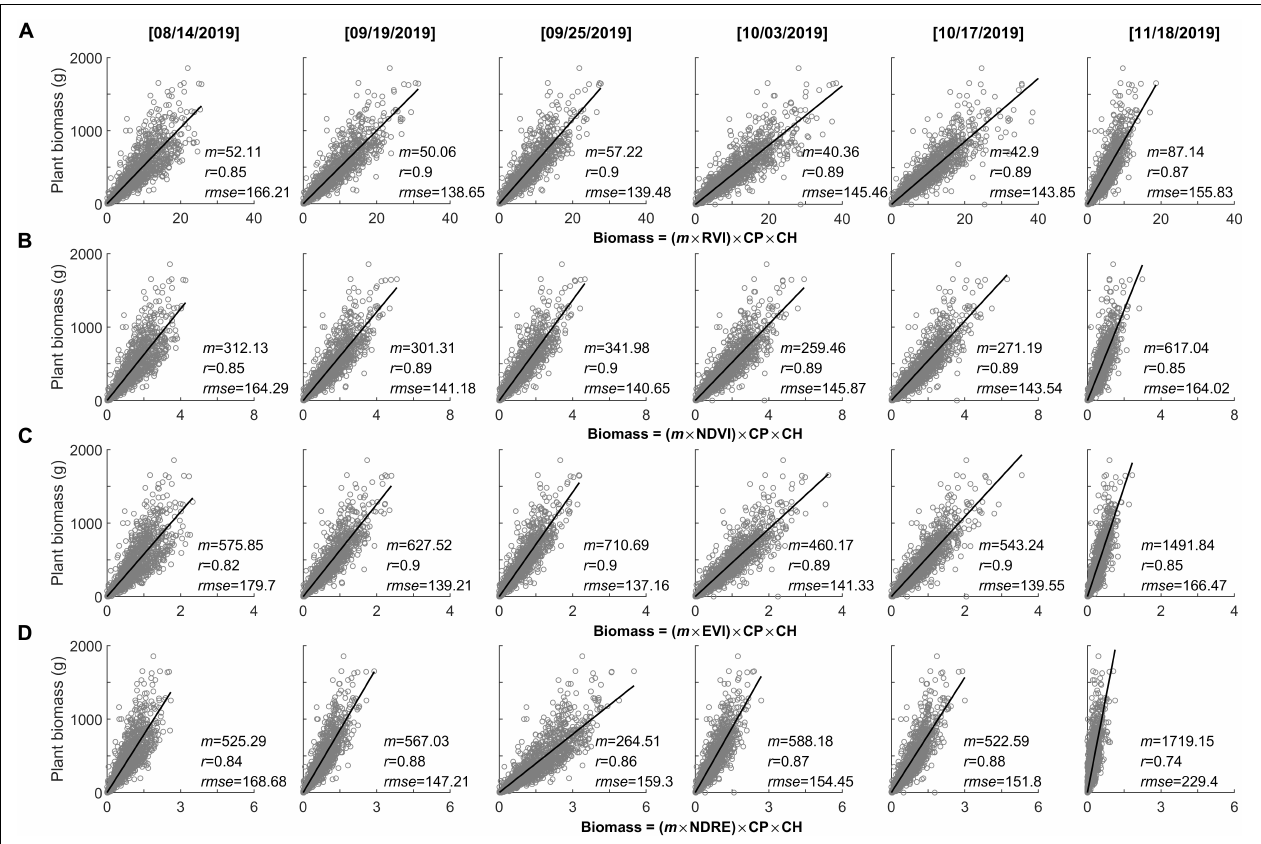
FIGURE 6 | Performance of the assembly of phenotyping measurements (CP, canopy perimeter; CH, canopy height) and spectral index in predicting the plant biomass with changes of the growing season, as well as a different spectral index. (A) RVI, (B) NDVI, (C) EVI, and (D)